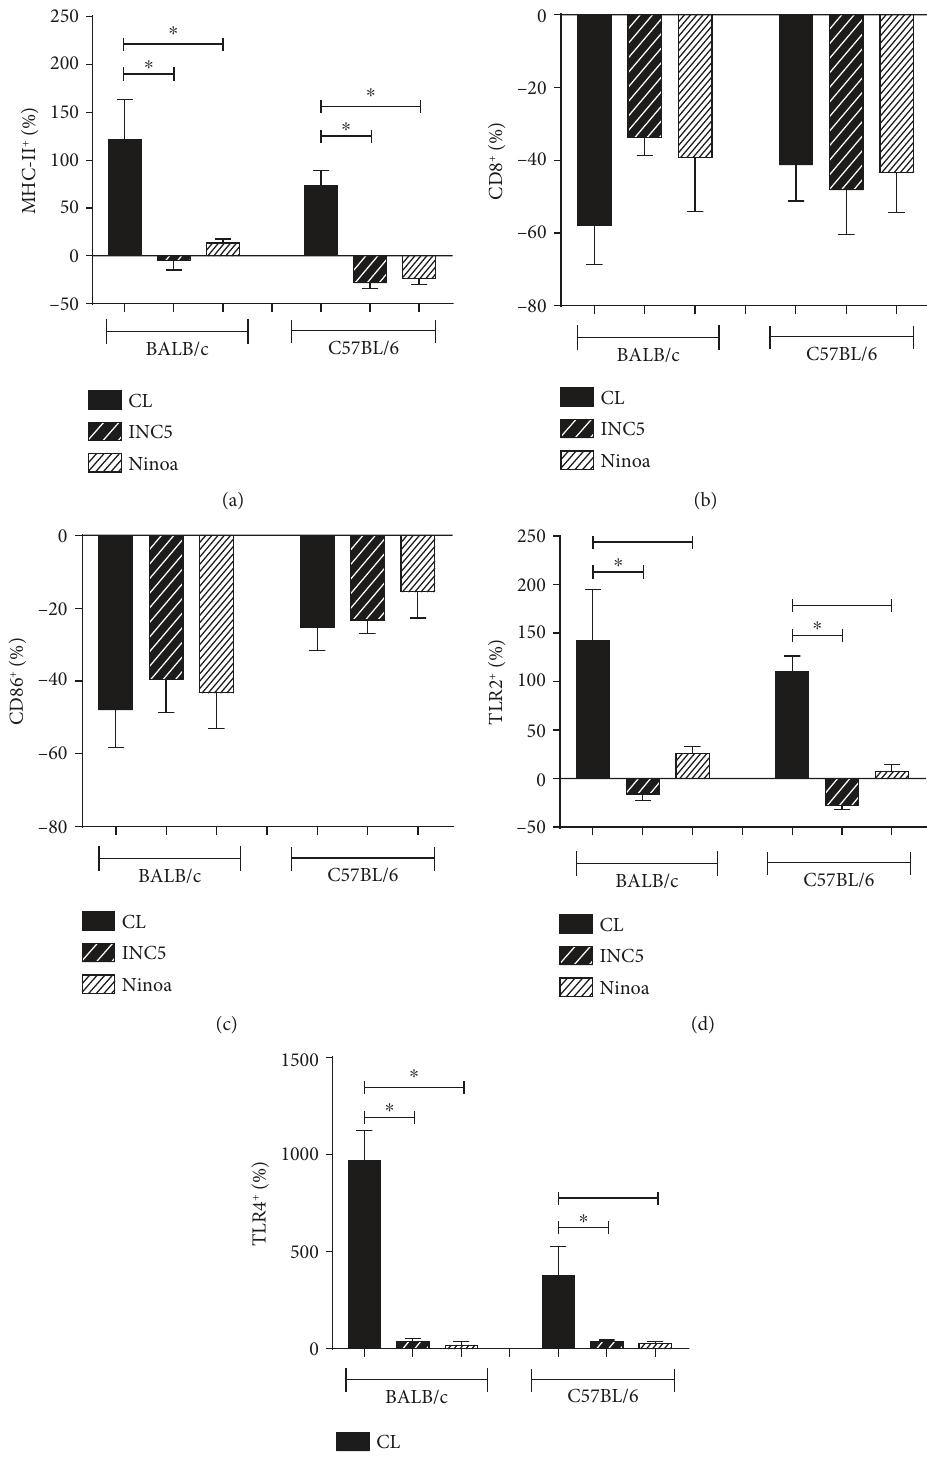
Figure 5: Percentage of BMDCs expressing MHC-II, costimulatory molecules, and toll-like receptors after in vitro T. cruzi infection. The expression of molecules was evaluated by fl ow cytometry and represented as a variation of the percentage of BMDCs expressing (a) MHC- II, (b) CD80, (c) CD86, (d) TLR2, and (e) TLR4. Statistical analysis, when applicable, was performed with the Kruskal-Wallis test with Dunn ’ s posttest, where ∗ p < 0 05